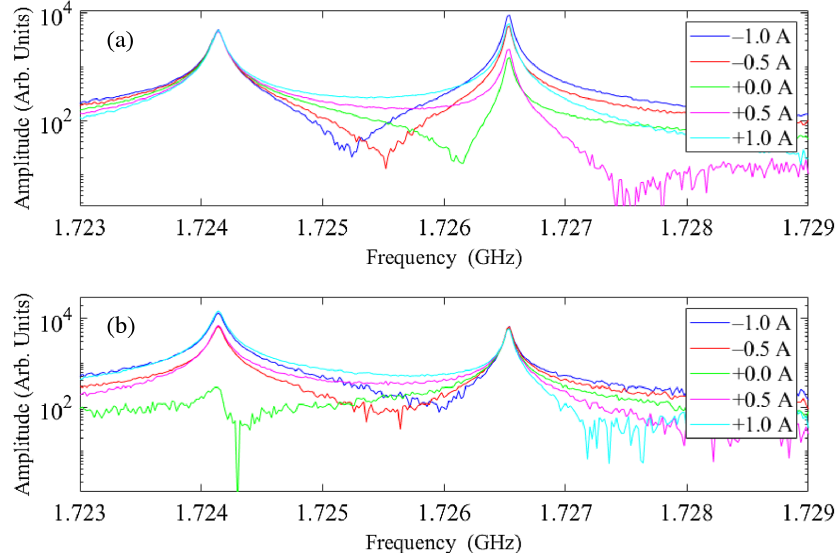
FIG. 13. Horizontal (a) and vertical (b) steering results showing polarization-dependent HOM variations and ∼ 2 -MHz frequency spitting of the two polarizations of dipolar mode 7 in CM2:C1 (AES).